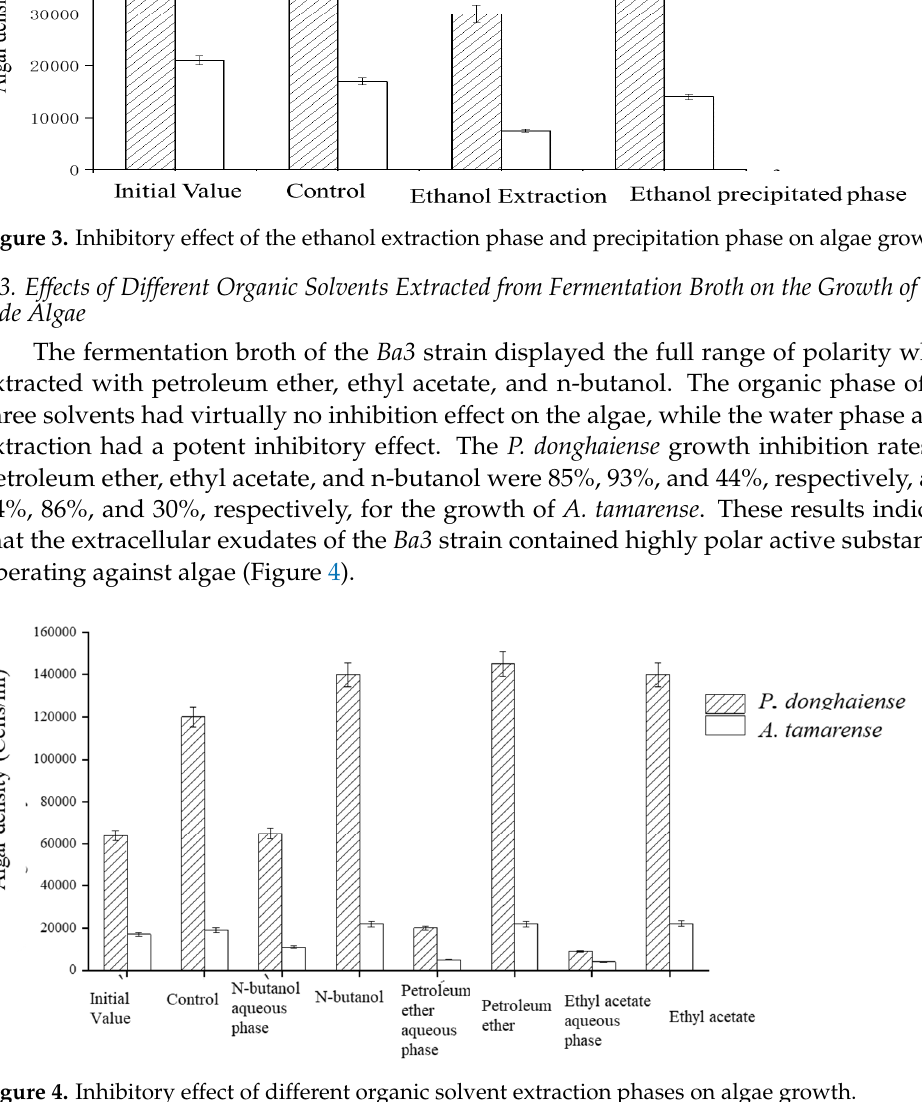
Figure 4. Inhibitory effect of different organic solvent extraction phases on algae